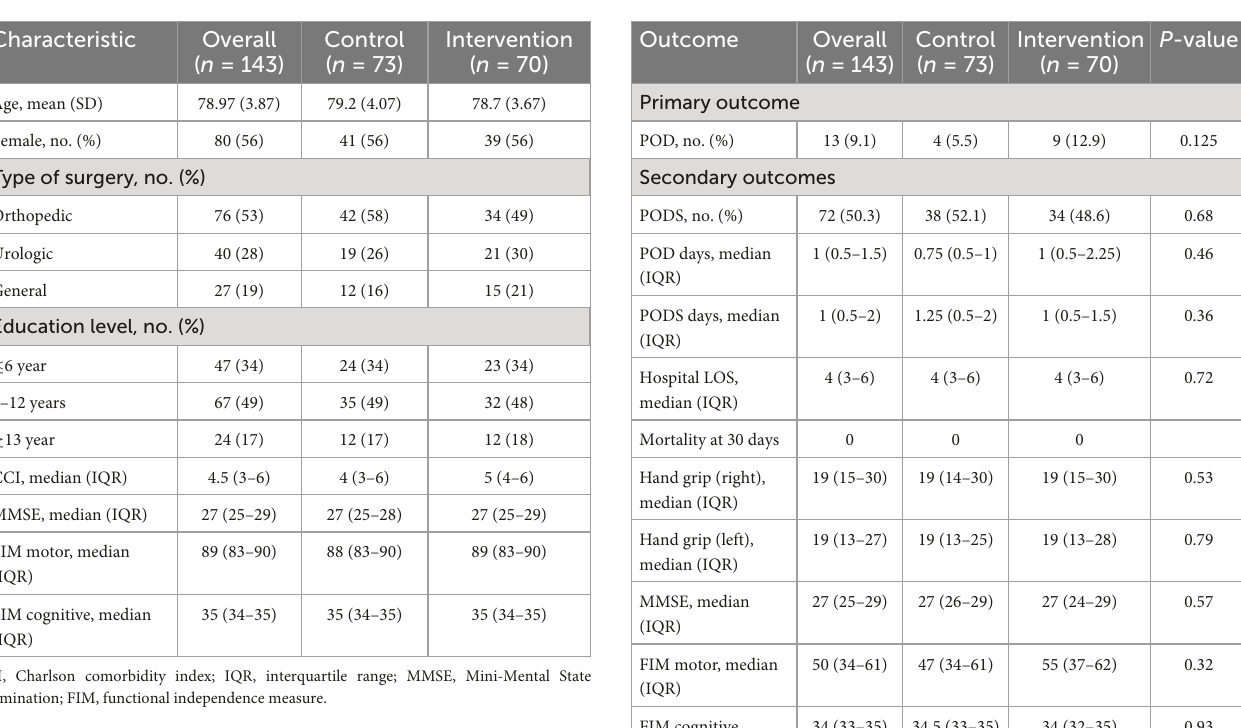
TABLE 1 Characteristics of patients at baseline. TABLE 2 Primary and secondary